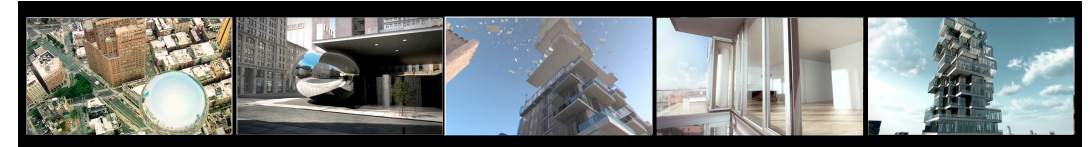
Figure 4. Herzog & d Meuron, 56 Leonard Street in New York. Movie by Tronic (Hong Kong, China) (2:06),